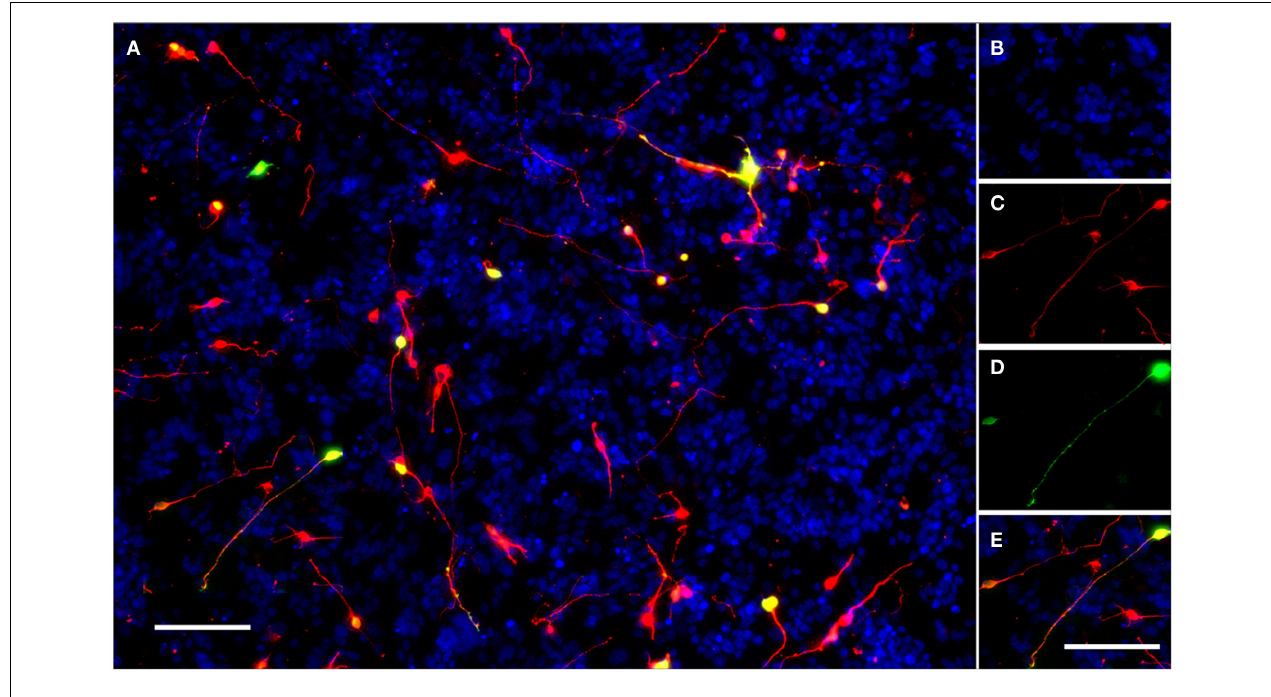
(B) DAPI stained nuclei of CHO-R2 cells and CGNs. (C) CGNs stained for beta-III-tubulin. (D) eGFP positive, transfected CGNs expressing GFP. (E) The merged image; transfected neurons appear yellow. Scale bars: 100 μ